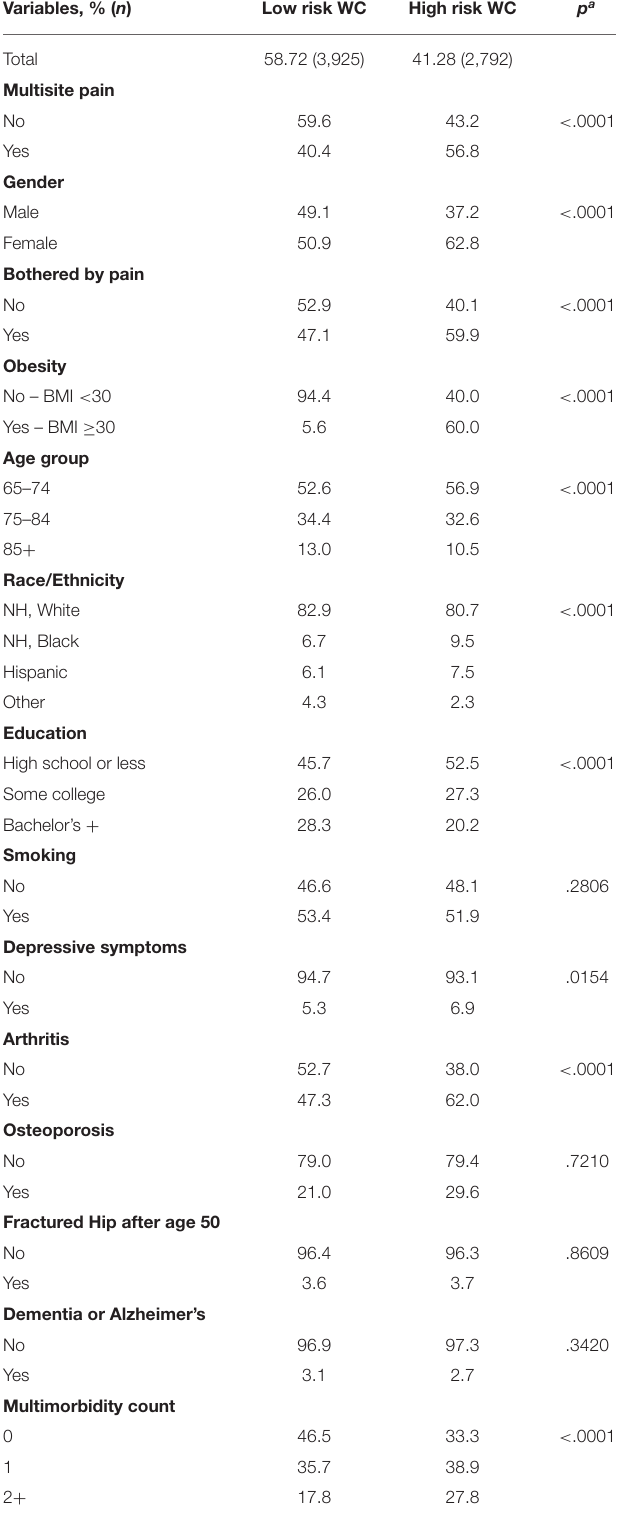
TABLE 3 | 2011 missing pain responses of national health and aging trends study participants by waist circumference (WC) risk level, for study of central adiposity and pain. Round, % missing